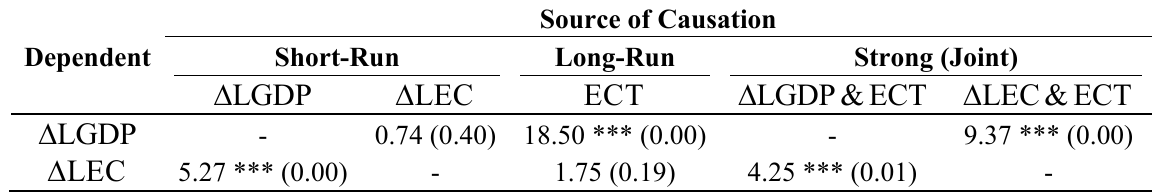
Table 7. Panel causality